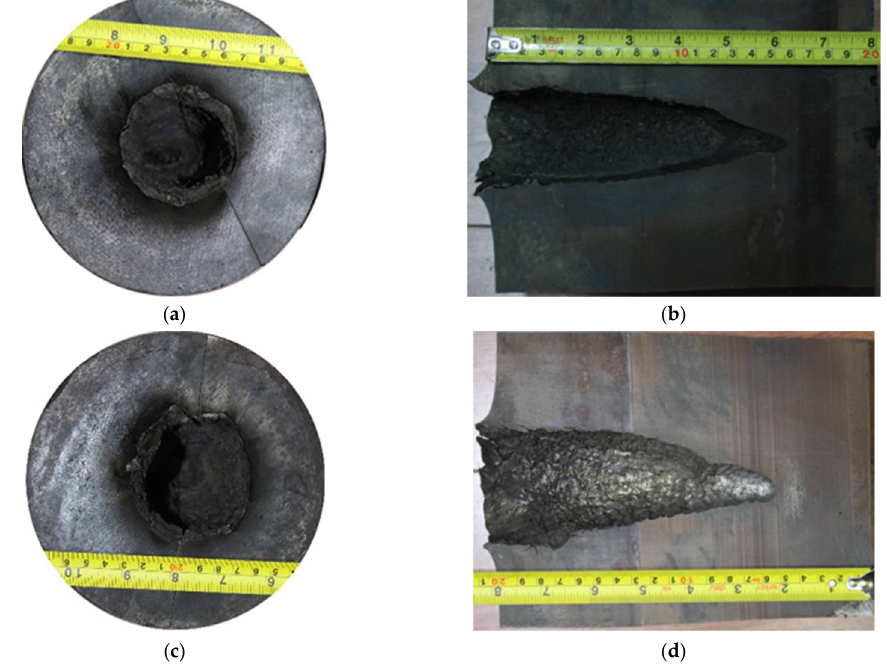
Figure 5. Steel target penetration results; ( a ) top view: PX-1; ( b ) section view: PX-1; ( c ) top view: PX-2; ( d ) section view: PX-2.